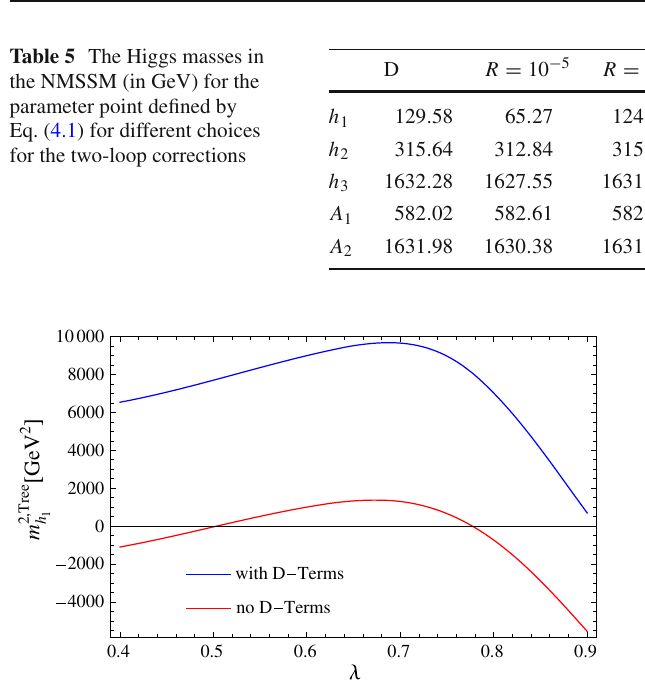
Fig. 2 Thelightestscalarmasssquaredfortheparameterpointdefined by Eq. (4.2) when calculating with and without D-term contributions 3. Goldstones set on-shell, with and without consistent tad- pole solutions, labelled OS and OS + Tad, respectively.